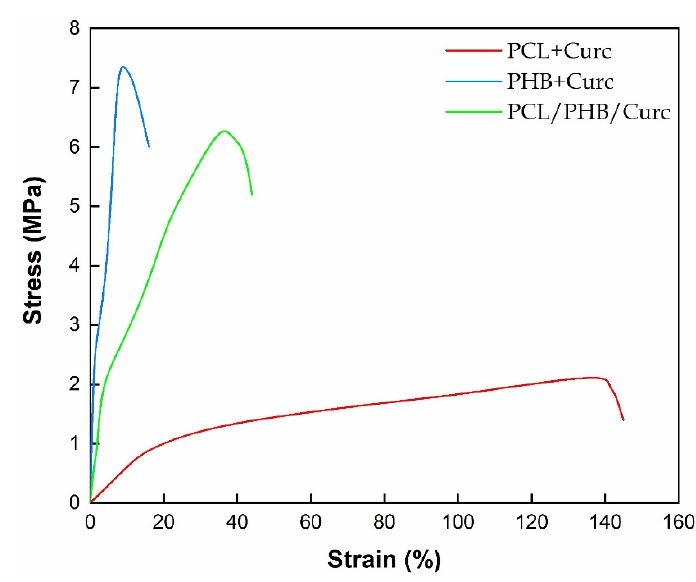
Figure 6. Stress–strain curves of electrospun membranes.